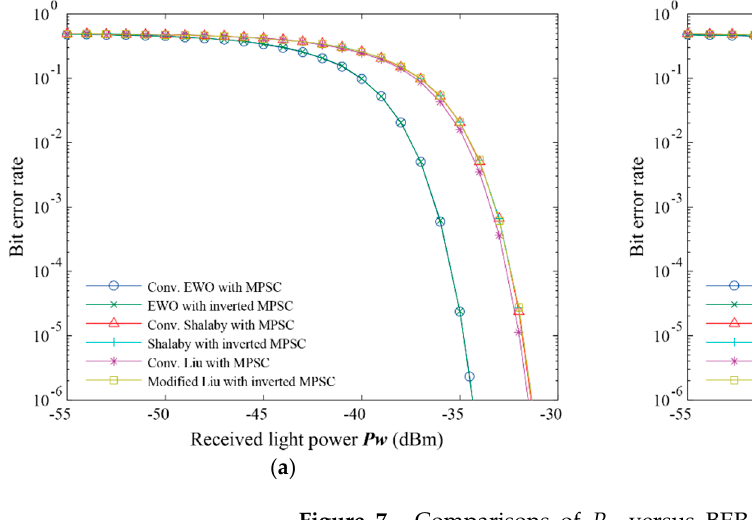
Figure 7. Comparisons of 𝑃 (cid:3050) versus BER performance . ( a ) 𝑞 = 4, 𝑁 (cid:2896) = 8, and 𝑁 = 8 , ( b ) 𝑞 = 8, 𝑁 (cid:2896) = 32,and 𝑁 = 32 .